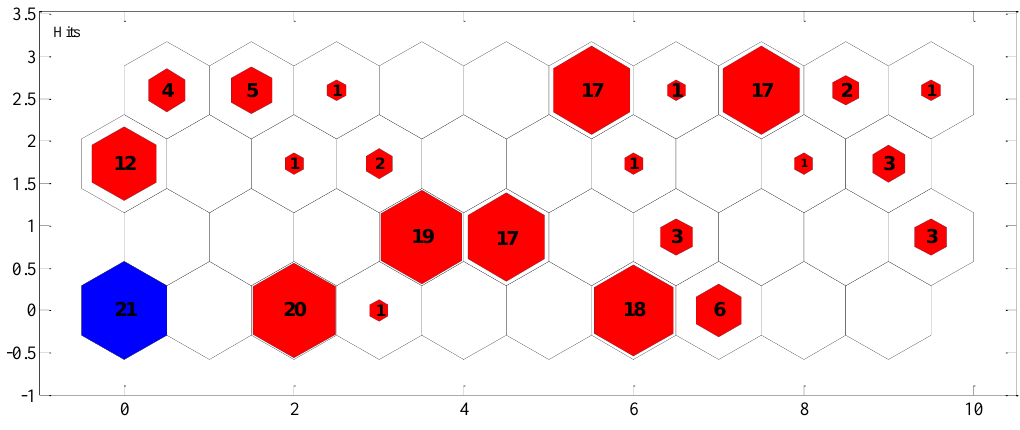
Figure 3. Statistics chart of winning neurons of self-organizing map (SOM) neural network.